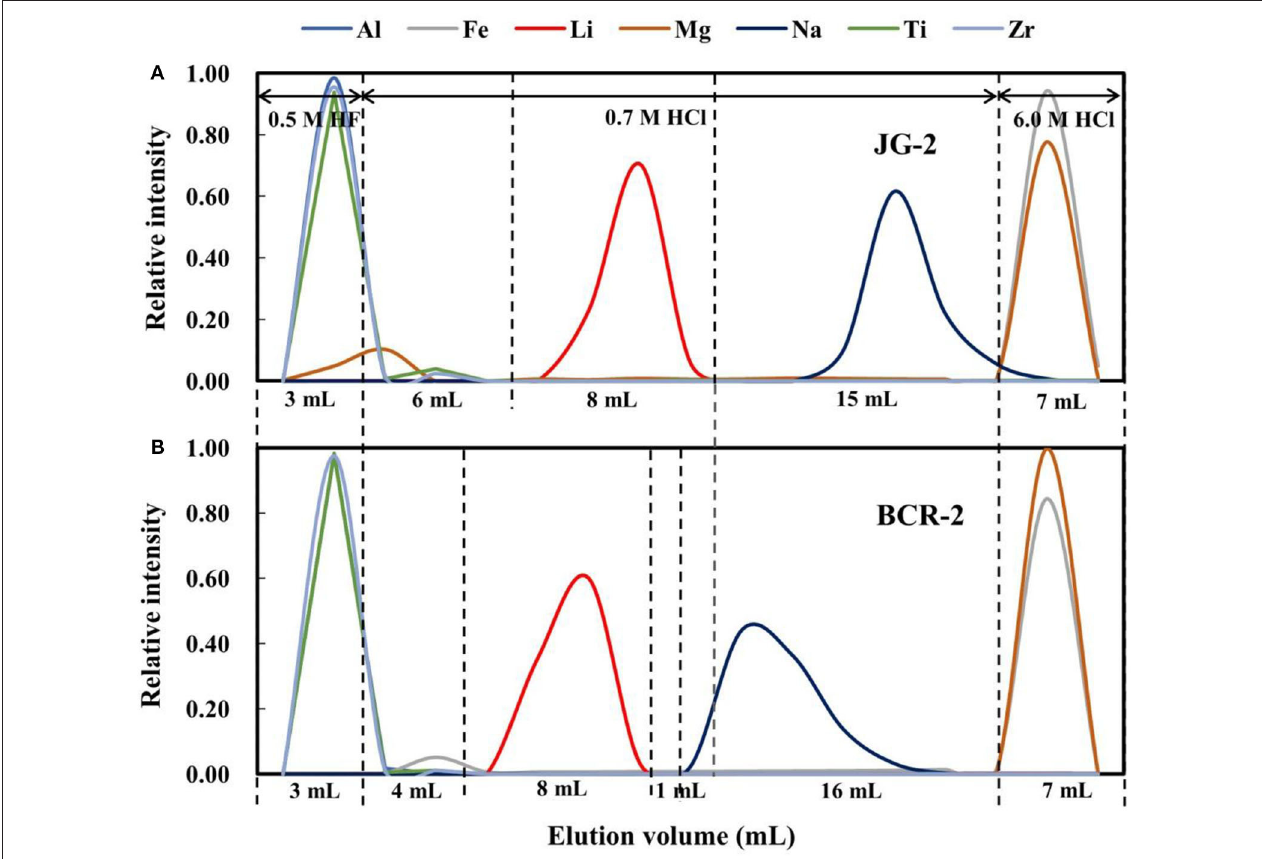
FIGURE 5 | Elution curves for (A) JG-2 and (B) BCR-2 on AGMP-50 using 0.5M HF and 0.7M HCl as an